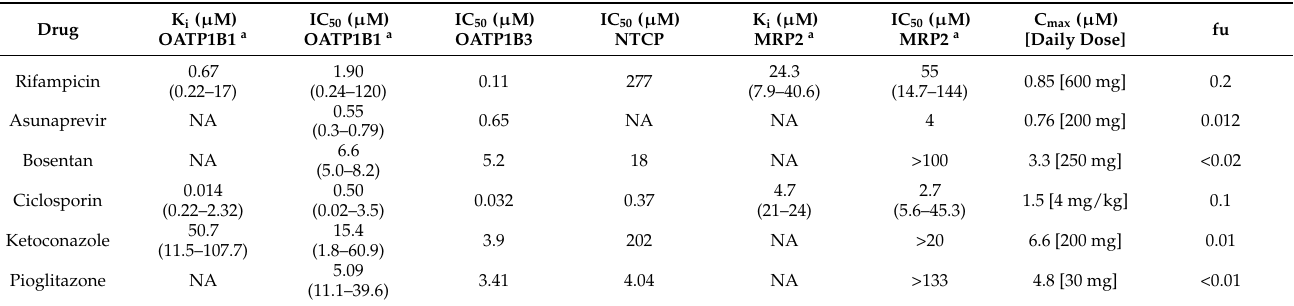
Table 3. In vitro inhibition constants (K i ) and half maximal inhibitory concentrations (IC 50 ) for selected drugs, against a range of human hepatic uptake and biliary efflux transporters and respective maximum unbound drug plasma concentrations (C max,u ) in humans. Data were extracted from published literature [30,43–49], regulatory review and prescribing documents [50–55], and